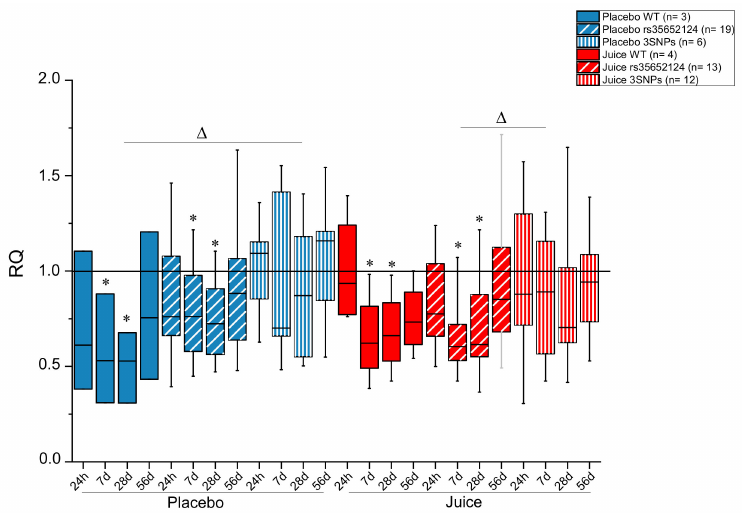
Figure 4. Impact of the consumption of anthocyanin-rich multi-fruit juice (Juice) and placebo bever- age (Placebo) on NFE2L2 transcript levels in peripheral blood lymphocytes (PBLs) of participants carrying different single nucleotide polymorphisms (SNPs) in the NFE2L2 promotor. NFE2L2 tran- script levels were normalized to ACTB and GAPDH levels and related to the control (levels at 0 h; RQ ± SD). Significance compared to the control is calculated by Kruskal–Wallis test with * = p < 0.05; significance relative to different subgroups with ∆ = p < 0.05. Abbreviations: WT = wild-type (without SNP); SNP rs35352124; 3SNP = Nrf2 promoter SNPs rs35352124, rs6706649 and